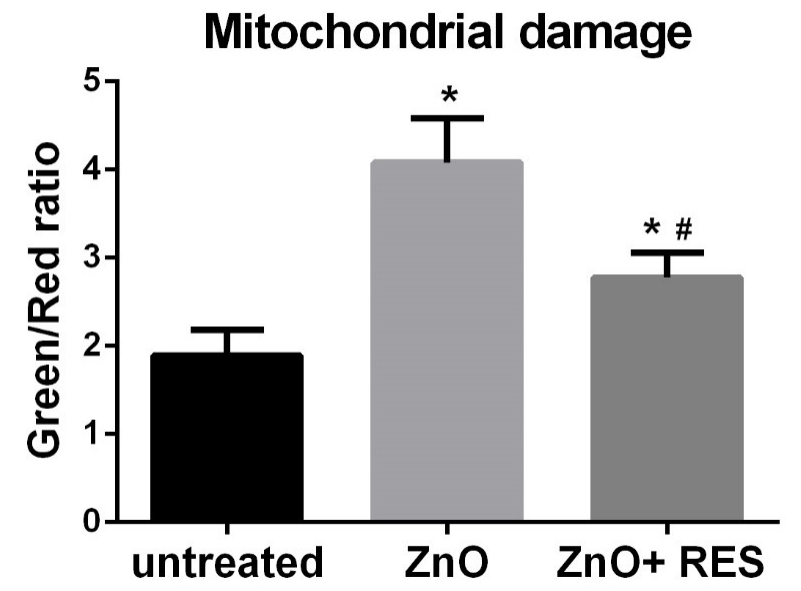
Figure 4. Resveratrol protects mitochondrial function in zebrafish embryos exposed to ZnO NPs. Quantification of mitochondrial damage (green/red fluorescence ratio) in 72-hpf embryos after treatment with 3 mg/L ZnO NP in the absence (ZnO) or presence (ZnO + RES) of 5 μM resveratrol. Embryos were stained with 5 μM JC-1 probe. Fluorescence was measured with a GENios plus microplate reader using a wavelength of 485 nm (excitation) and 535 nm (emission). RES, resveratrol. Values are shown as mean ± SD, n = 5. *, significantly different from untreated; #, significantly different from ZnO.